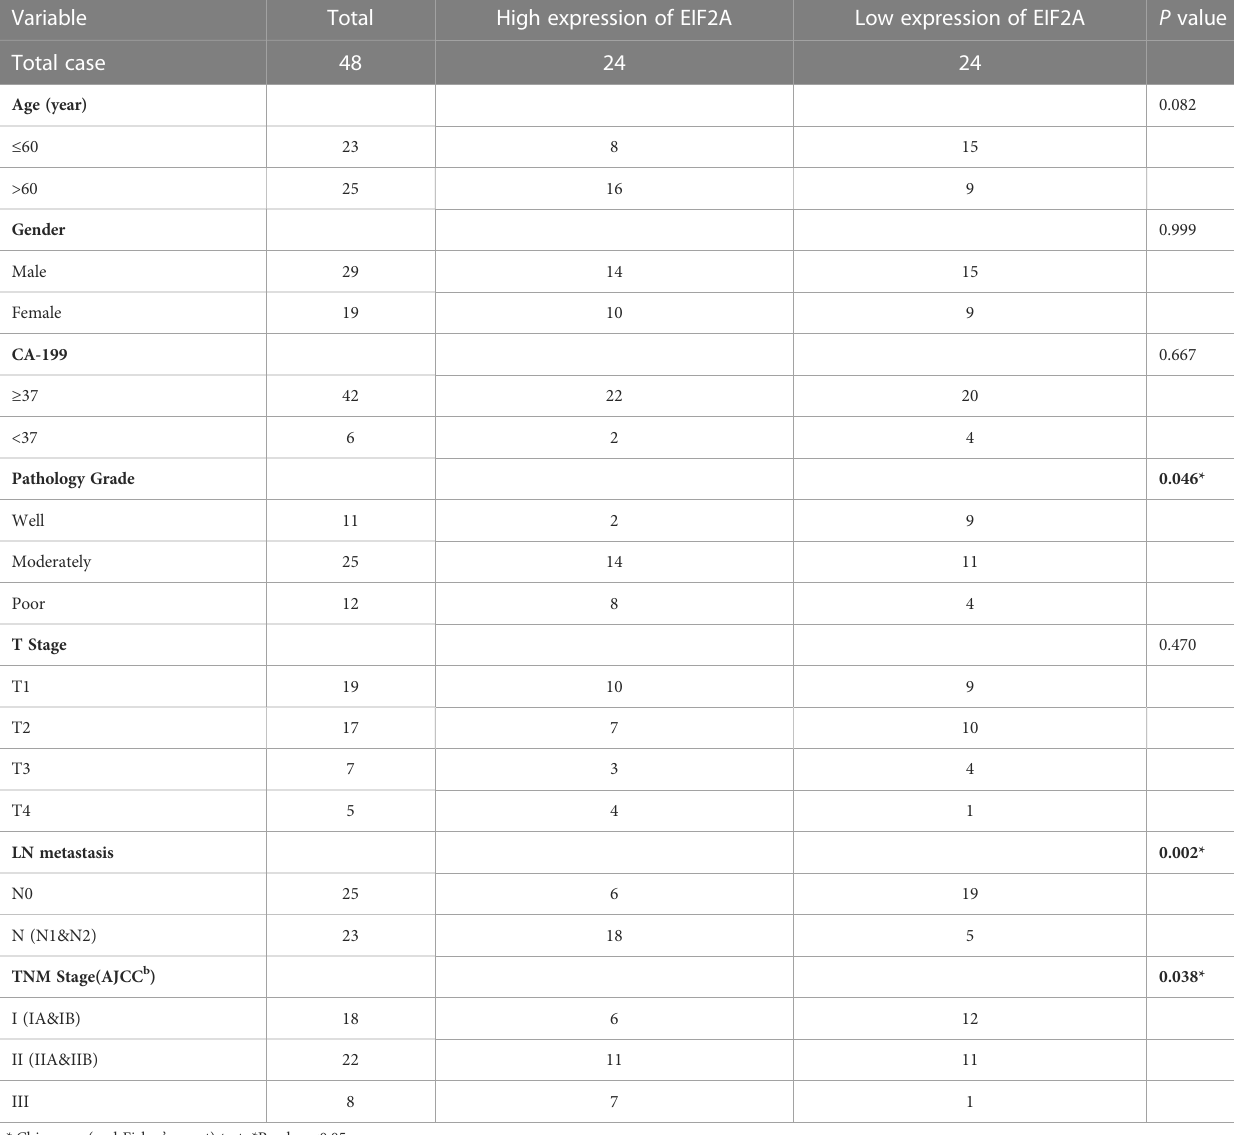
TABLE 1 Correlation between EIF2A expression and clinicopathologic characteristics of PDAC patients a .